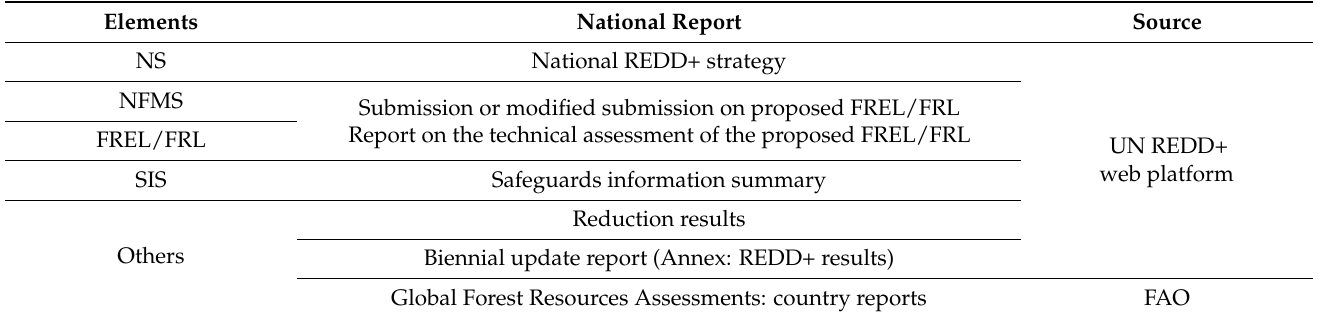
Table 1. Source of data collected for the